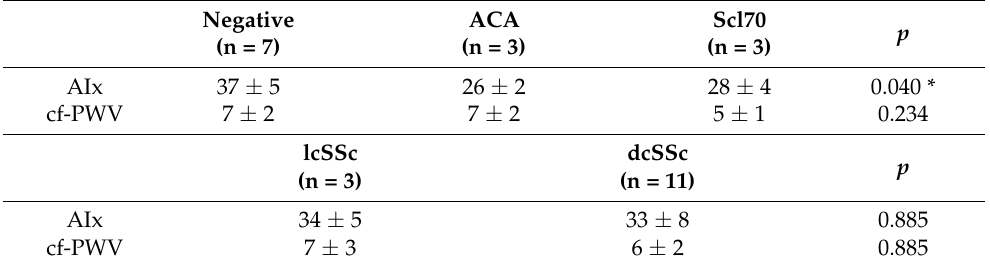
Table 4. Arterial stiffness measurement in the clinical and serological subtypes of SSc